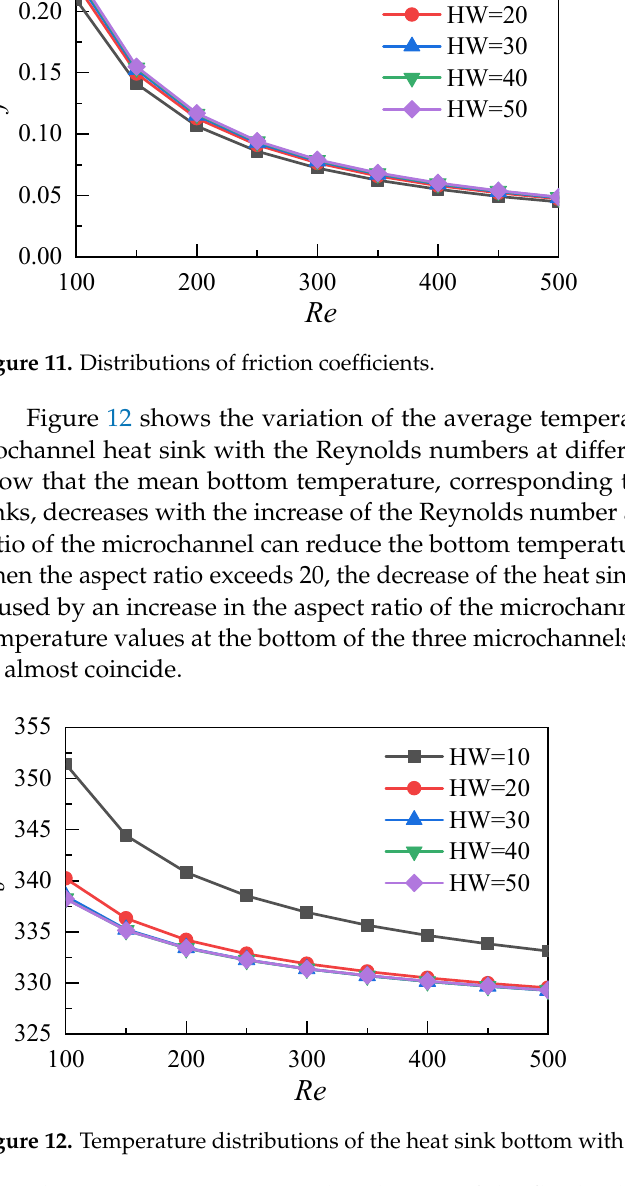
Figure 12. Temperature distributions of the heat sink bottom with different aspect ratios.